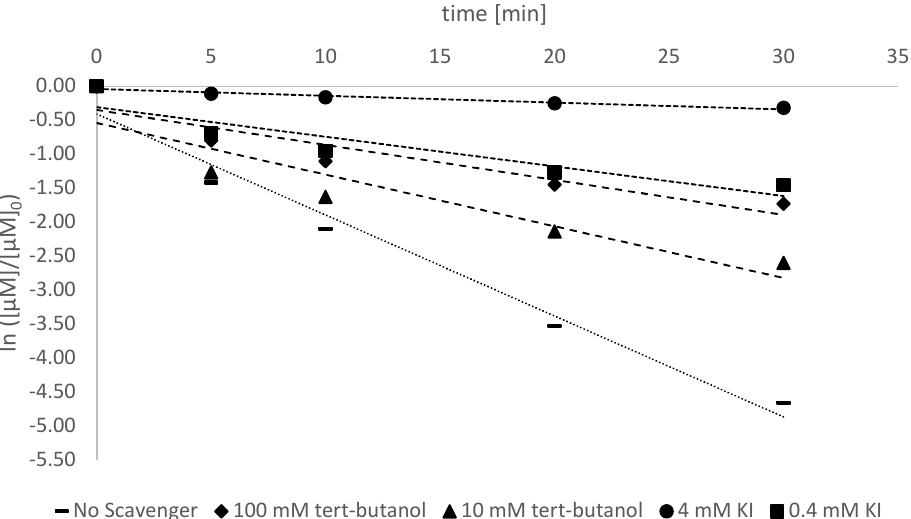
Figure 5. Trend of first-order kinetics following selective inhibitions with tert-butanol and KI. Values refer to Z30-Ps.